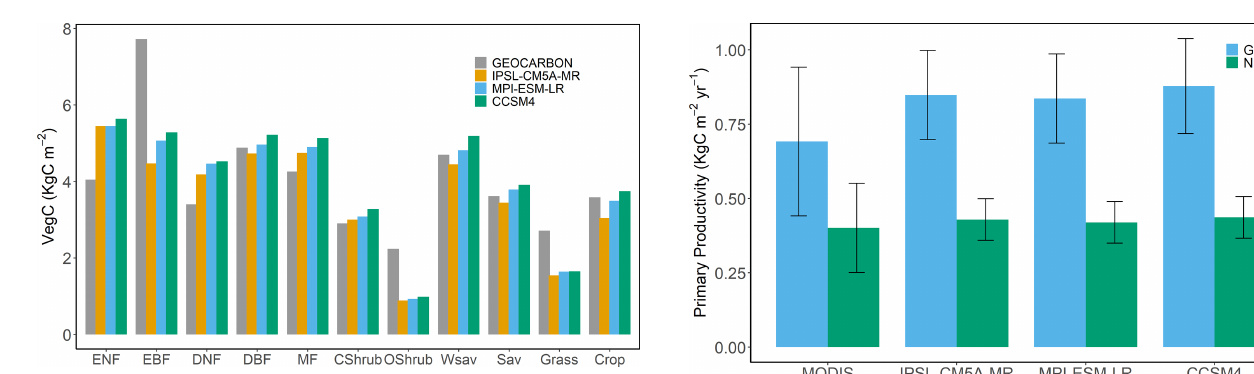
Figure 4. GPP and NPP for HKH showing mean GPP (blue) and mean NPP (green) from MOD17 and from the LPJ-GUESS model forced by climate outputs from the three ESMs (average for the period 2000–2010). Vertical black bars illustrate ± standard error, where n =